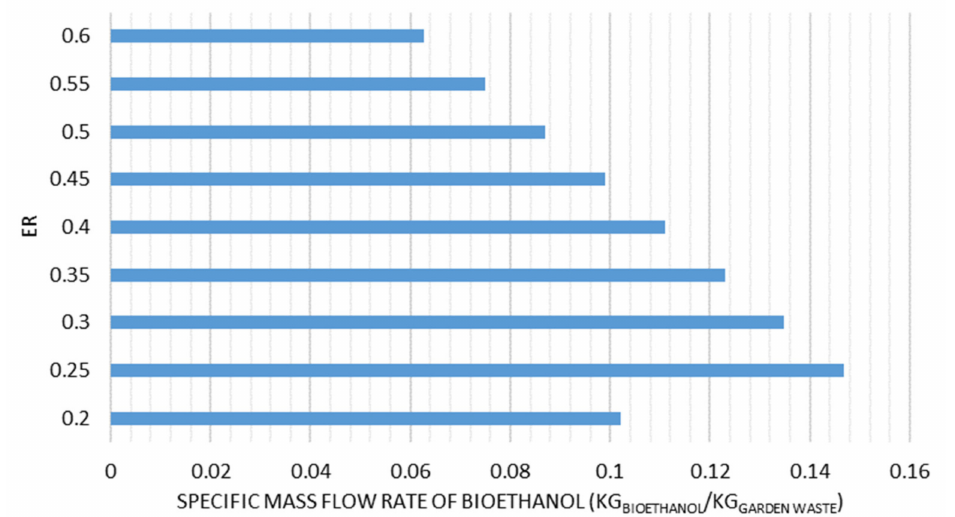
Figure 8. E ff ect of ER on the specific mass flow rate of bioethanol